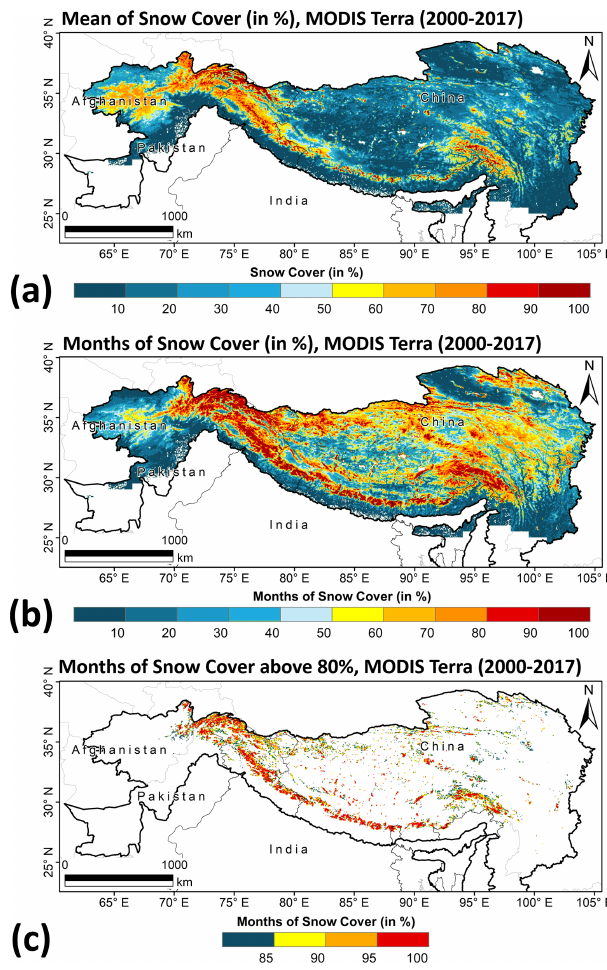
Figure 1. The spatial distribution of MODIS–Terra-derived (a) monthly mean snow cover (in percent), (b) the total duration of the presence of snow cover (in percent) out of 204 months, and (c) the presence of snow cover above 80% (total months out of 204 months) during March 2000 to February 2017 over the HKH